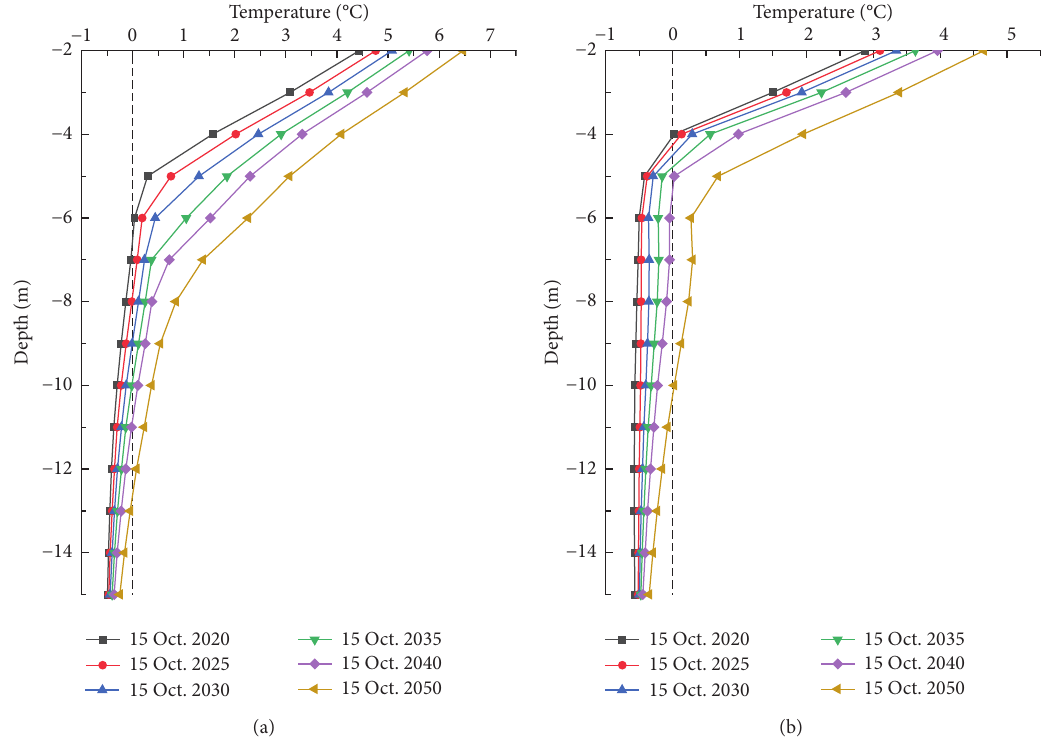
Figure 10: Simulated ground temperature profiles on Oct. 15th at the sunny shoulder (a) and the shady shoulder